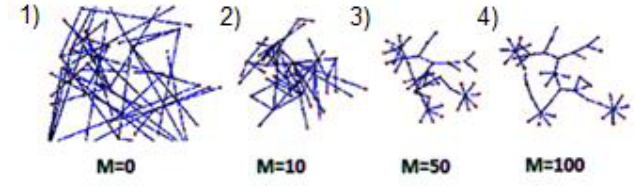
Fig. 1 Emerging of force-directed graph pattern.